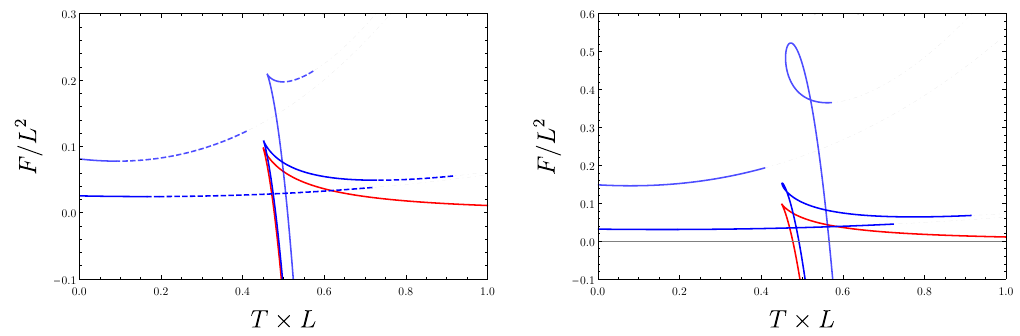
Figure 7 . Hawking-Page transition in five dimensions . Left : here we show a plot of the free energy vs. temperature for the five dimensional uncharged black holes. The red curve corresponds to the Einstein gravity case, the dark blue curve corresponds to µ = 2 . In each case, solid curves indicate that both the mass and entropy corresponds to µ = 10 µ c − | | − are positive, while a dashed curve indicates that the Wald-Entropy is negative. The blue curves terminate when the mass becomes negative. Right : the same plot as on the left, but now using the shifted entropy as described in the